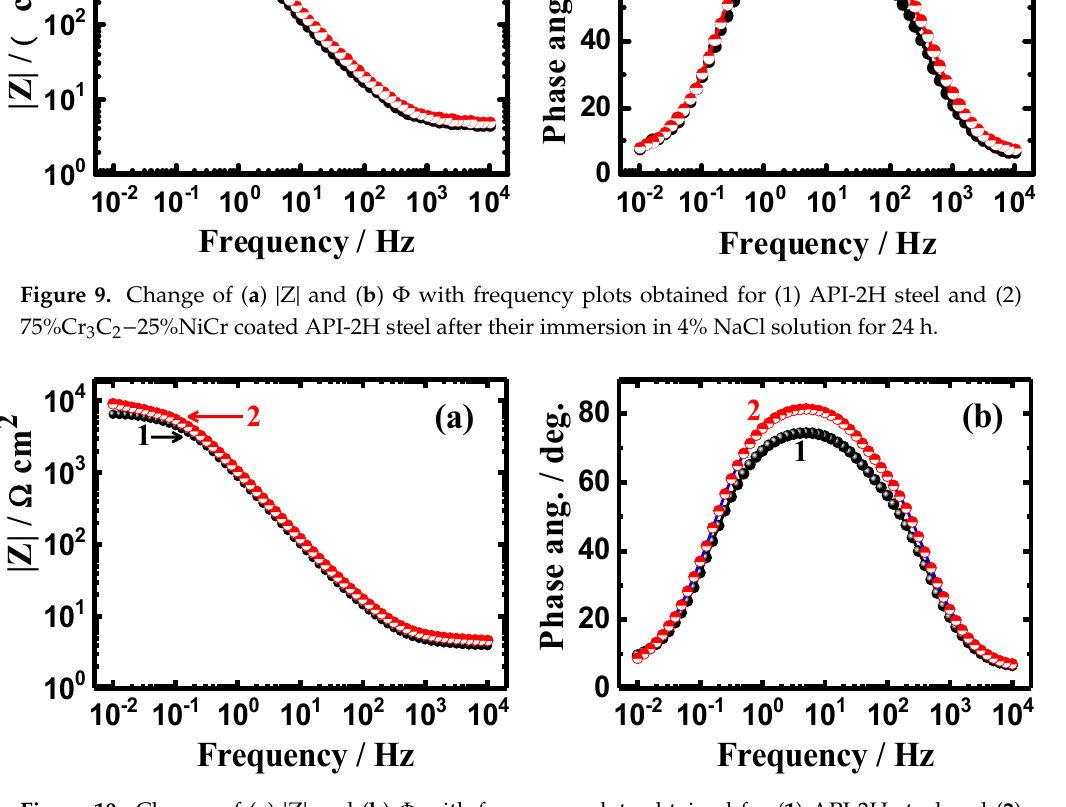
Figure 10. Change of ( a ) | Z | and ( b ) Φ with frequency plots obtained for ( 1 ) API-2H steel and ( 2 ) 75%Cr 3 C 2 − 25%NiCr coated API-2H steel after their immersion in 4% NaCl solution for 48 h.